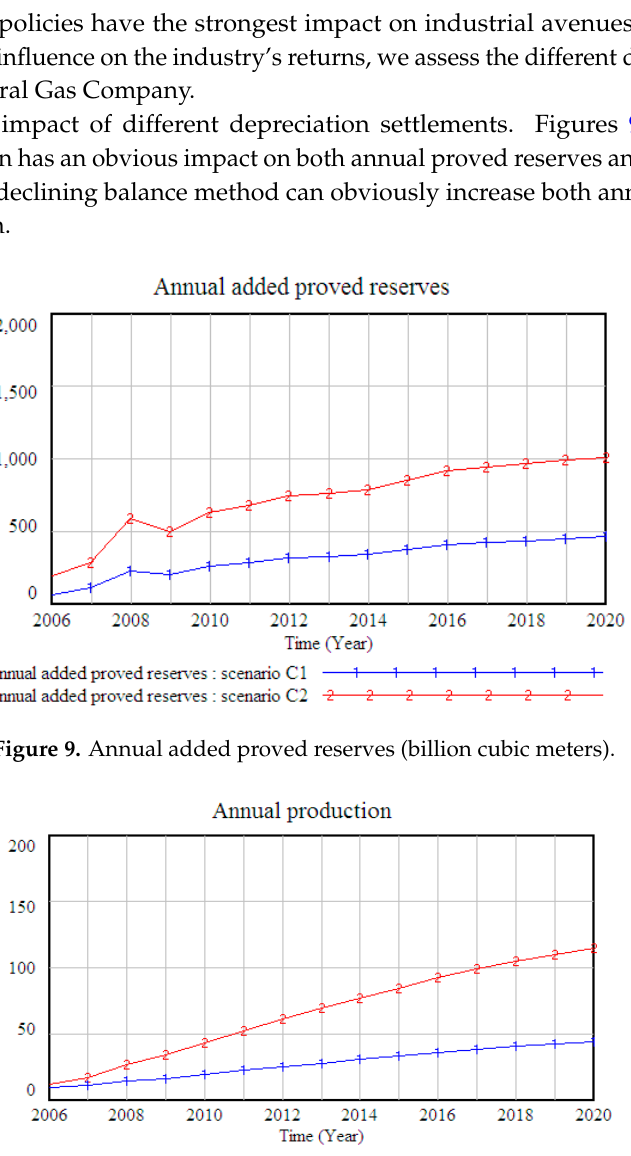
Figure 11. Annual added proved reserves (billion cubic meters).